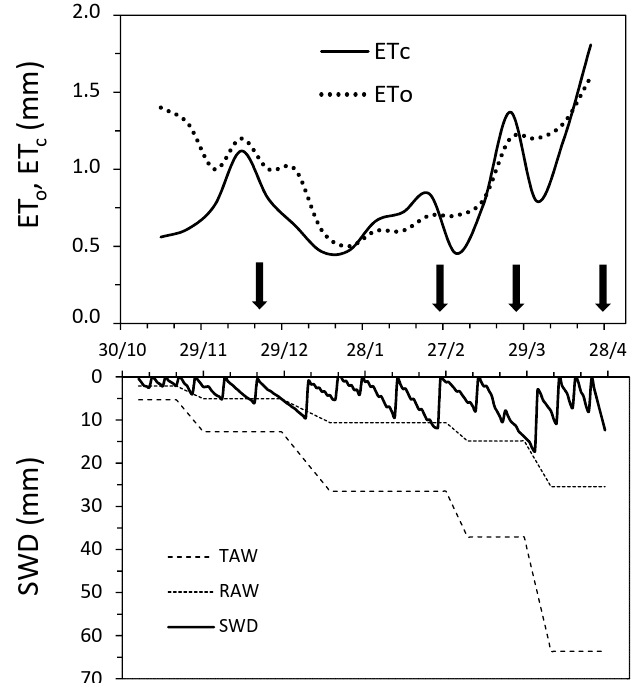
Figure 1. Trend of reference evapotranspiration (ETo), crop evapotranspiration (ETc), and soil water depletion (SWD) during the wild rocket crop cycles. TAW = Total Available Water, RAW = Ready Available Water. Arrows indicate collection dates.